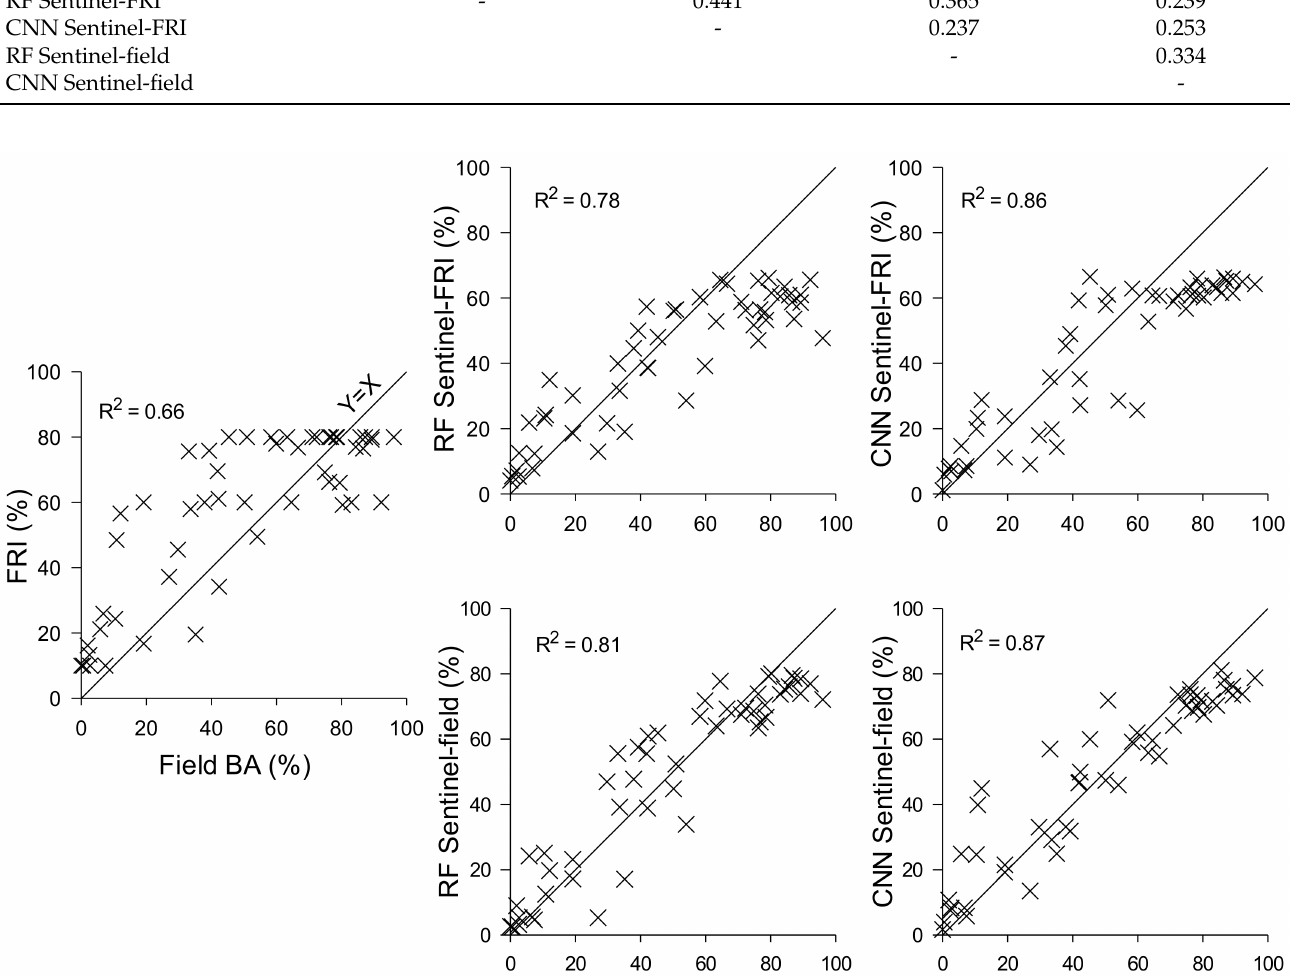
Figure 5. Percent canopy composition of sugar maple from: (1) the Forest Resource Inventory (FRI), (2) Sentinel-FRI random forest (RF) predictions, (3) Sentinel-FRI convolutional neural network (CNN) predictions, (4) Sentinel-field RF predictions, and (5) Sentinel-field CNN predictions plotted against percent basal area (BA) of stems ≥ 10 cm diameter in 51 0.24-ha field plots in the “Megaplot”. See text for